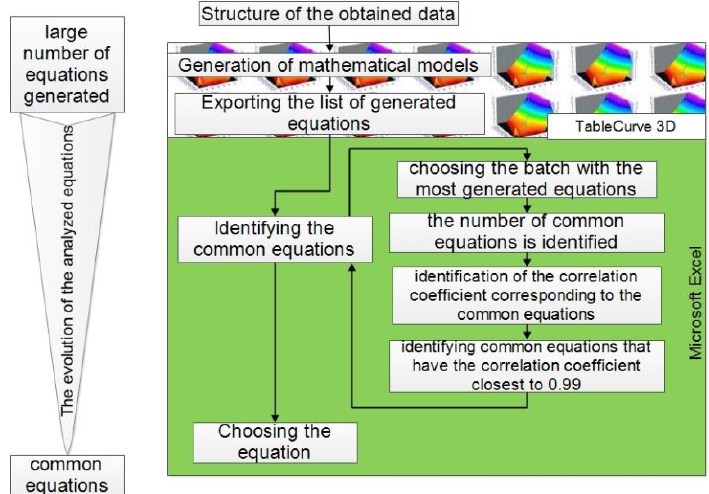
Figure 11. Identifying common equations: a working methodology.